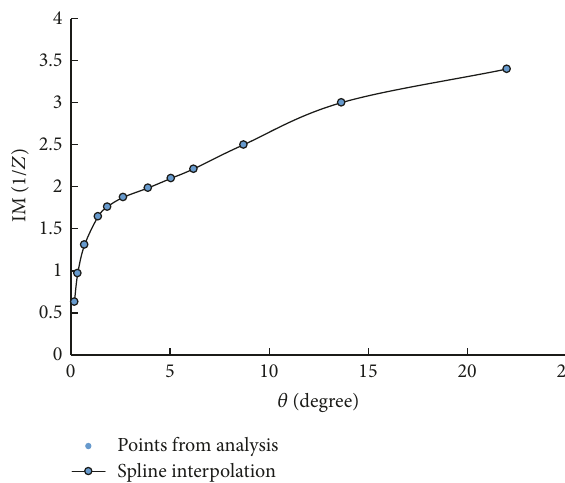
Figure 1: The obtained IM-DM points for (300, 7) for different IM